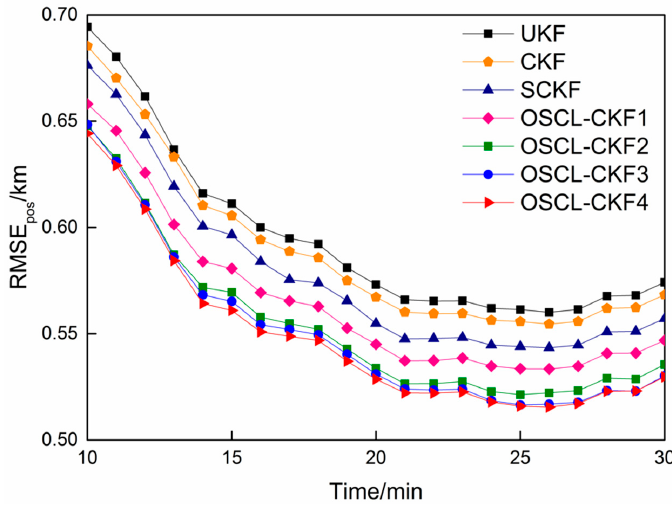
Figure 3. The position root MSE (RMSE) of various algorithms. UKF—unscented Kalman filter.